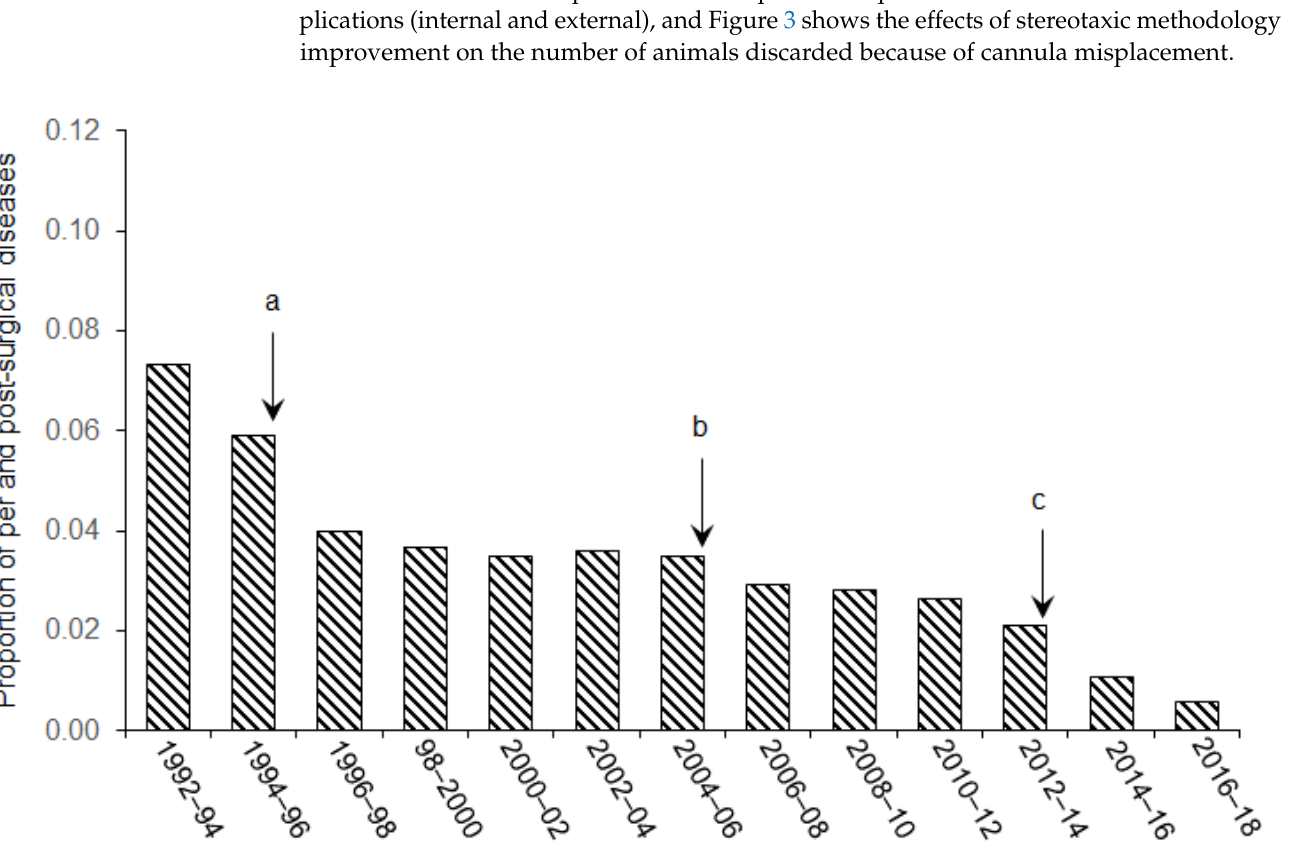
Figure 1. Effect of refinement in anesthesia, pain management, and rehydration on animal post-surgical recovery. Letters indicate the chronology of various improvements introduced in the surgical procedure. ( a ) From 1994 to 1996, internal temperature has been monitored and maintained. Systematic i.p. injection of 5 mL of NaCl and heating of the animal at the end of surgery have been used. Involvement of animal facilities staff in pain control methods including daily post-surgical care and nursing. Individual follow-up sheet which lists all the substances the animal received during the different periods covering the surgery (pre-, per-, and post-surgery) and daily evaluation of signs of pain and distress is completed for each animal. ( b ) From 2004 to 2006, diazepam/xylazine or sodium pentobarbital anesthetics have been gradually replaced by the association of ketamine and xylazine. ( c ) From 2012, systematic i.p. injections of 5 mL of glucose Ringer lactate 5% and a subcutaneous injection of an anti-inflammatory have been given at the end of the surgery in order to control